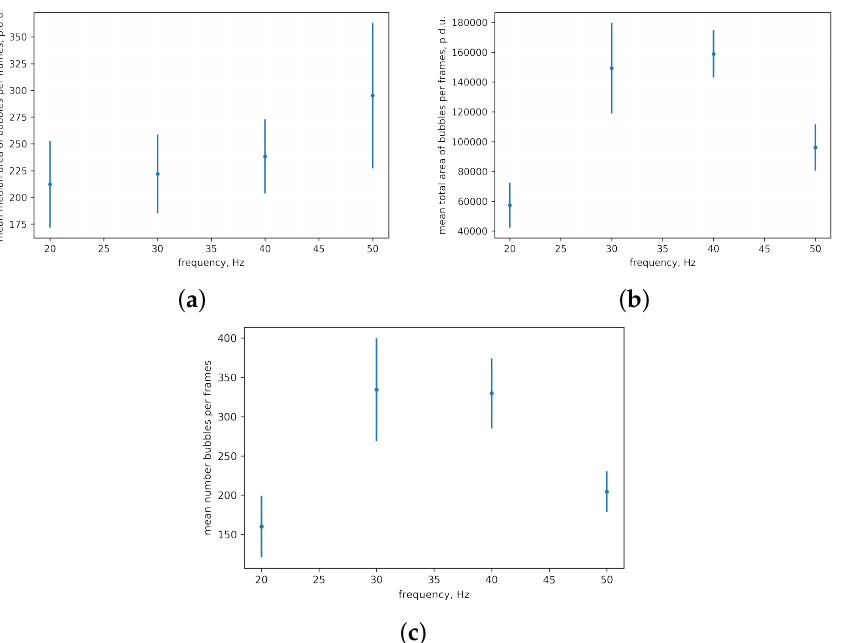
Figure 23. Ratio between ( a ) median area, ( b ) total area, ( c ) number of bubbles and the bioreactor mode. The number and the total area seems to be highly correlated for various bioreactor modes; thus, they have the ability to indicate the chosen mode, unlike the median area. Furthermore, note the area estimation has a lower variance so it might be more preferred to use it in the following calibration of the results. However, it requires more experiments to measure and justify the ratios more